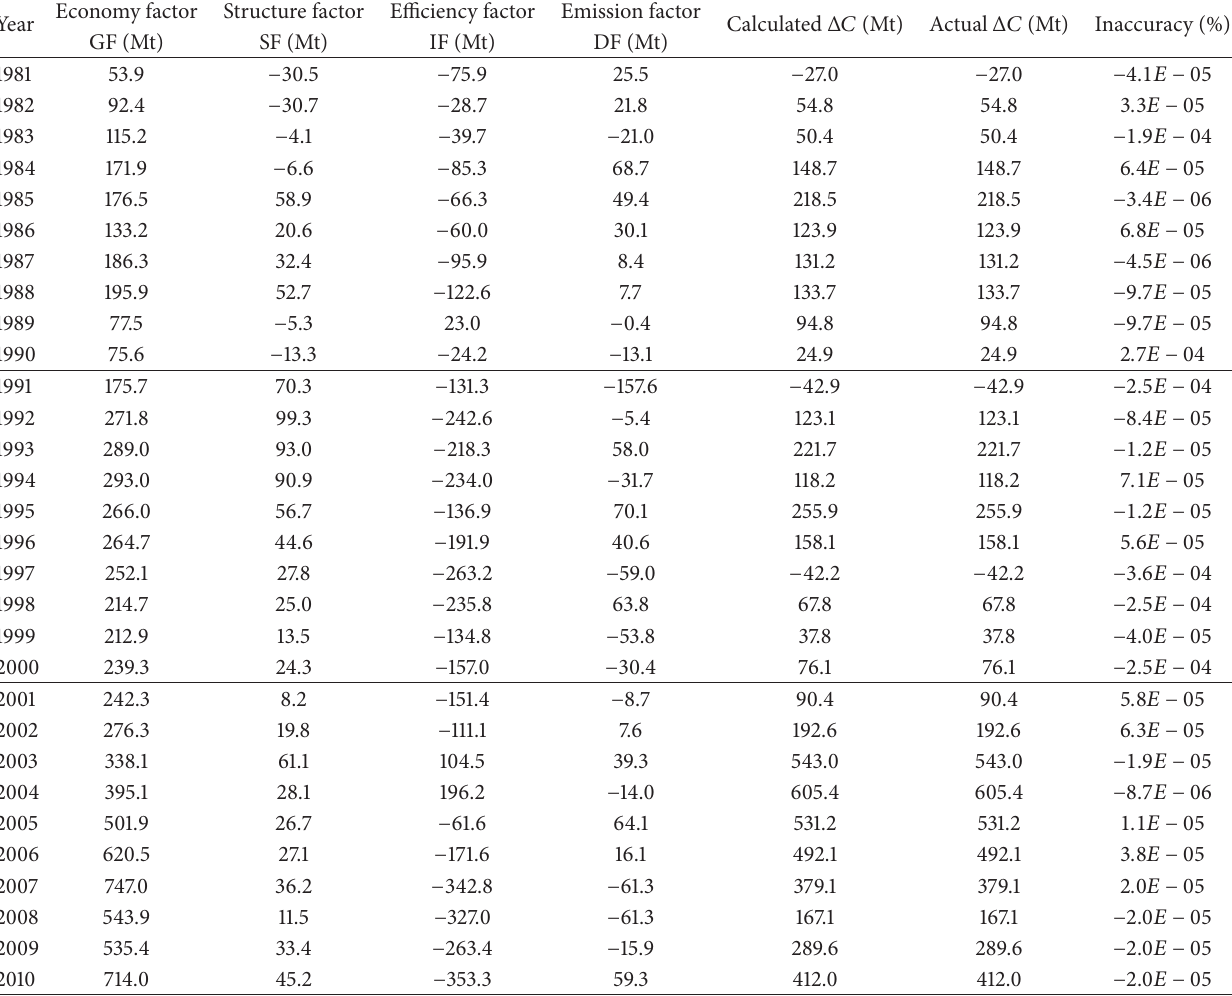
Table 5: Decomposition results of industrial sector CO